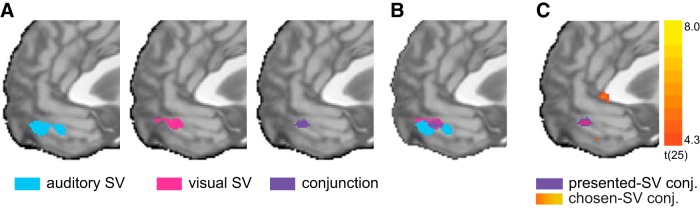
Common value representations across sensory modalities. Whole-brain random-effects maps; n = 26. A, Significant voxels tracking aSV, vSV, and a conjunction between the two modality-specific SV predictors (aSV ∩ vSV). B, All three maps superimposed on each other. C, Conjunction between the two modality-specific chosen SV predictors (aCSV ∩ vCSV), superimposed on the presented subjective-value conjunction map. All maps are shown at MNI coordinate x = 0. All maps are at p < 0.05 (FDR corrected) but shown in different thresholds for presentation purposes (aSV at z = 6.5, vSV at z = 4, conjunction at z = 4.3).